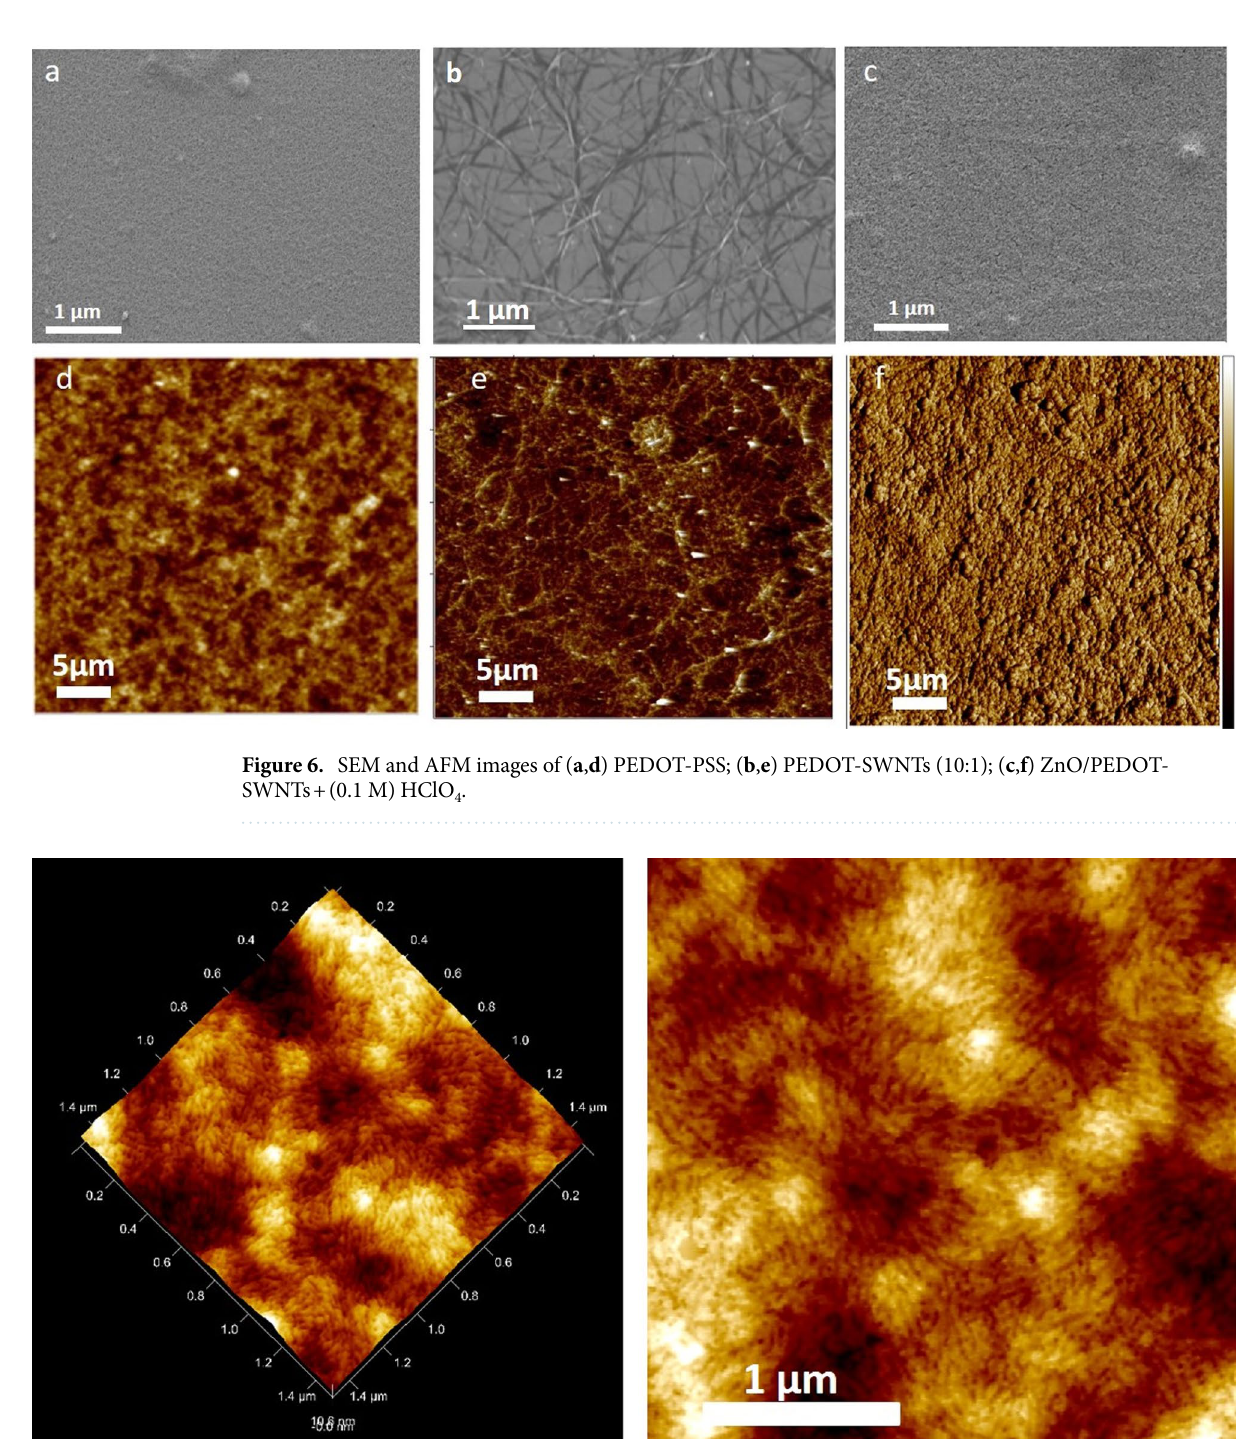
Figure 7. AFM image of PTB7- PC71BM (1:1.5 w/w) under 3D (right) and 2D images